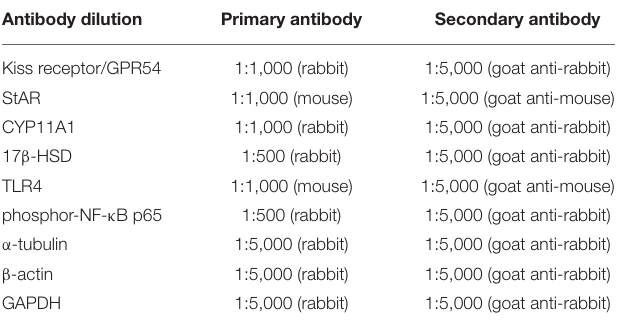
TABLE 1 | The antibody dilution.